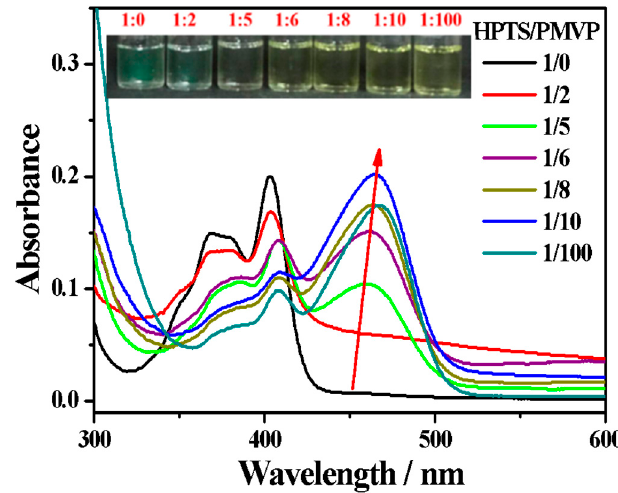
Figure 1. UV–Vis absorption spectra of 8-hydroxy-1,3,6-pyrenetrisulfonic acid trisodium salt (HPTS) (0.01 mM) in water at different charge ratios of HPTS: PMVP. Inset shows that the complex color with different charge ratios of HPTS: PMVP changes under daylight. PMVP is the abbreviation of PMVP 41 - b -PEO 205 ( poly( N -methyl-2-vinylpyridinium iodide)- b -poly(ethylene oxide) ).